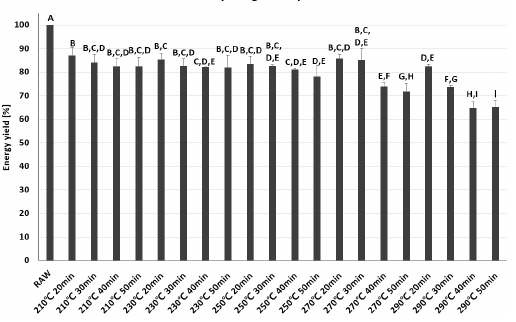
Figure 5. Energy yield of each pellet for various temperature and time conditions. Each letter in the graph is a group of significance determined by Duncan’s multiple test.